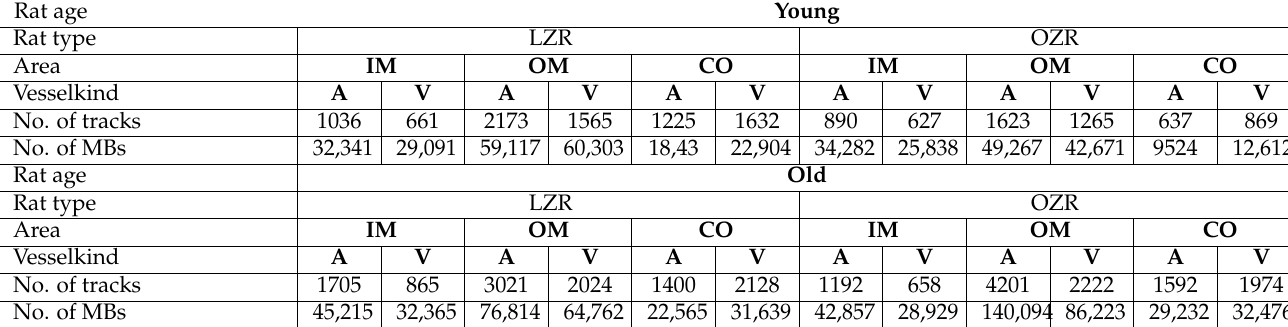
Table 3. Comparison of renal vascular density between lean Zucker rats (LZR) and obese Zucker rats (OZR) at the age of 11 and 20 weeks.